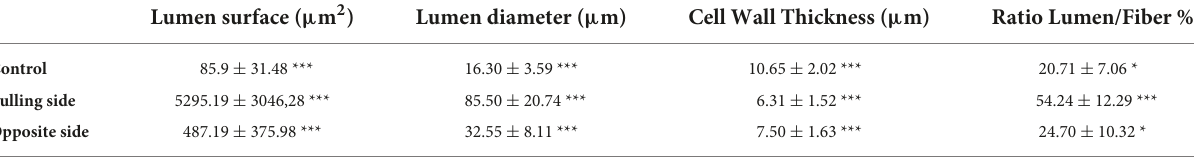
TABLE 1 Morphometric parameters of control and gravitropic stressed